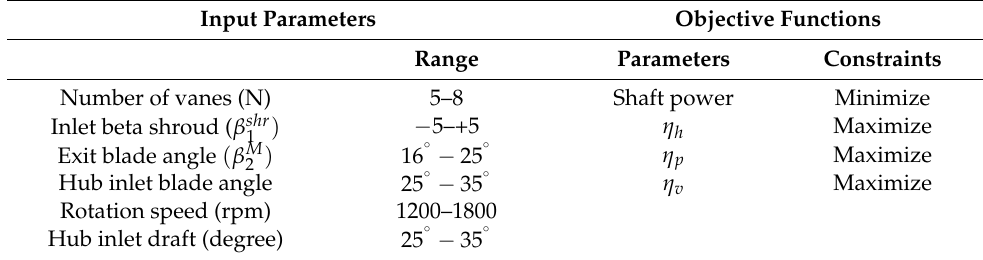
Table 5. Details for inlet and outlet